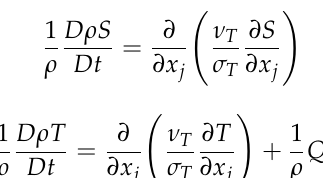
Table 1. Salinity and temperature for March (*) 2001 and for June (**) 2001, according to observations [57–60]. Stations St1 St2